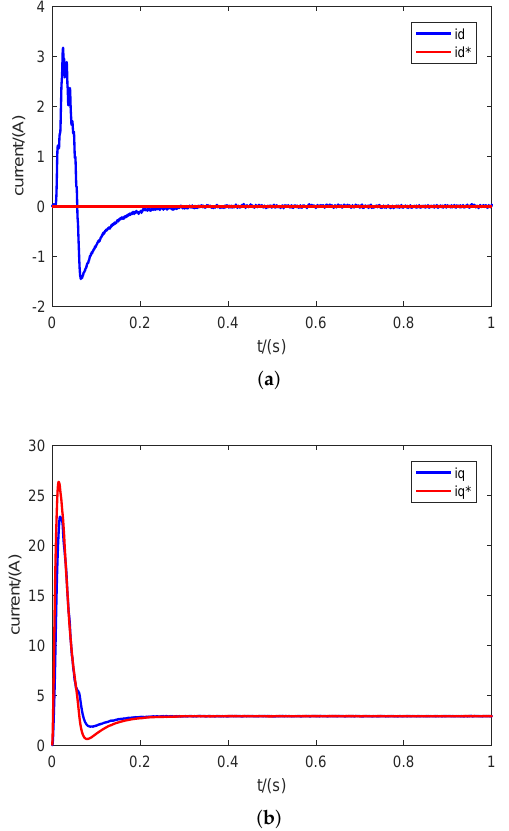
Figure 7. Simulation results with PI control method under the parameter disturbance: ( a ) d-axes current and ( b ) q-axes current.